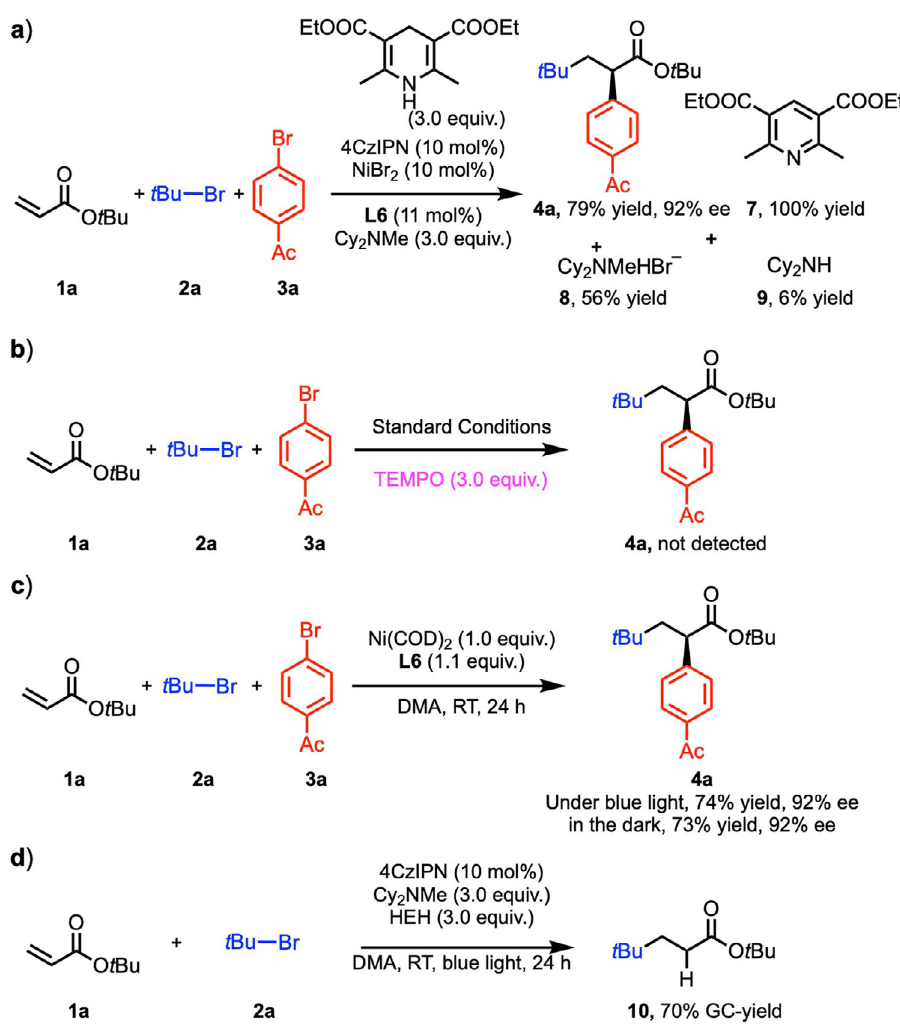
Fig. 2 Mechanistic experiments. a Detail analysis of the model reaction. b Radical trapping reaction via TEMPO. c Stoichiometric studies. d Intermediate veri fi cation